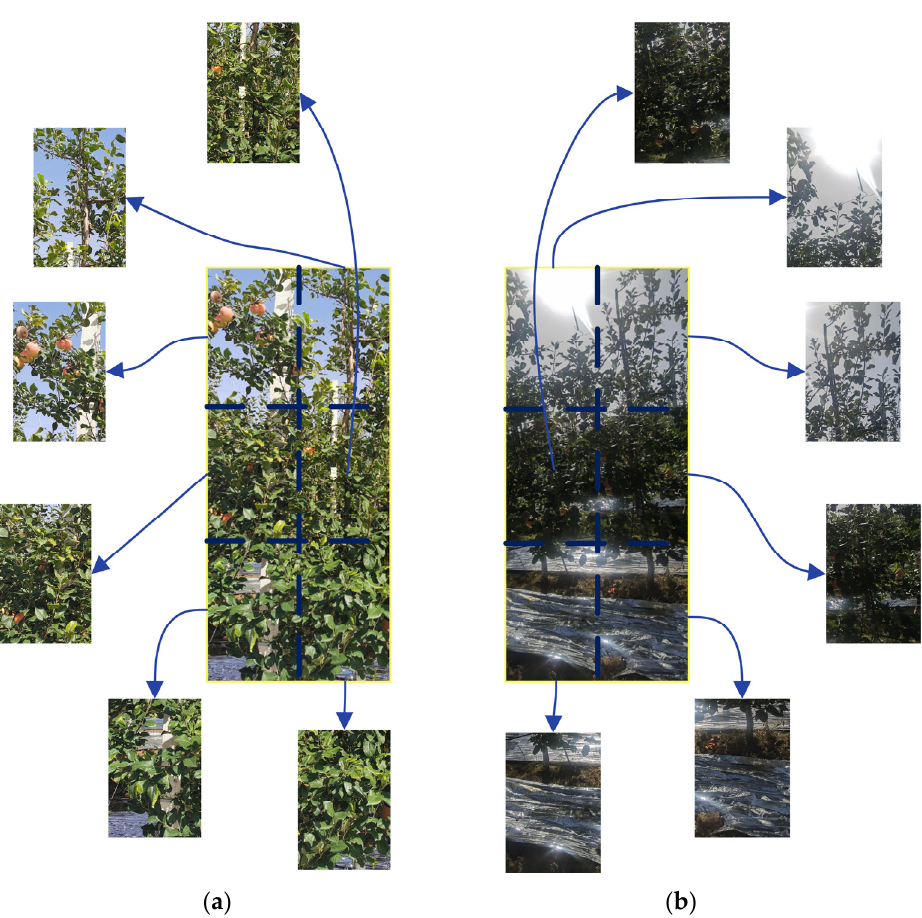
Figure 2. Sample dataset. ( a ) Data sample in front-light. ( b ) Data set sample in back-light.